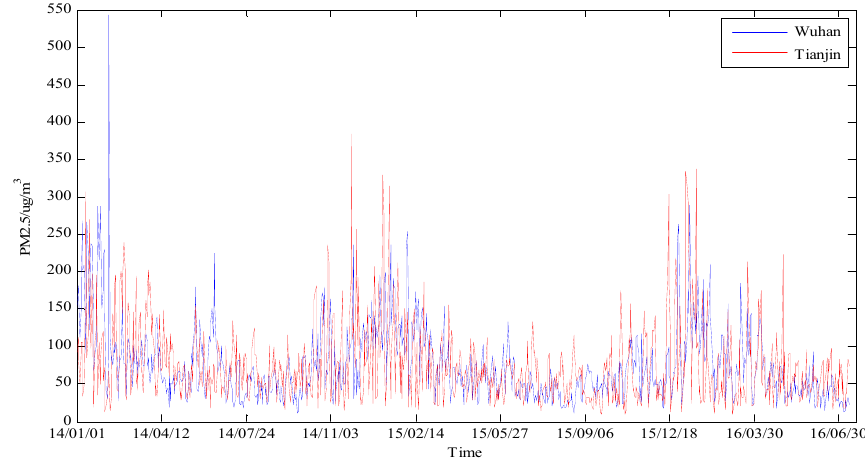
Figure 7. The original PM 2.5 concentration series of Wuhan and Tianjin.